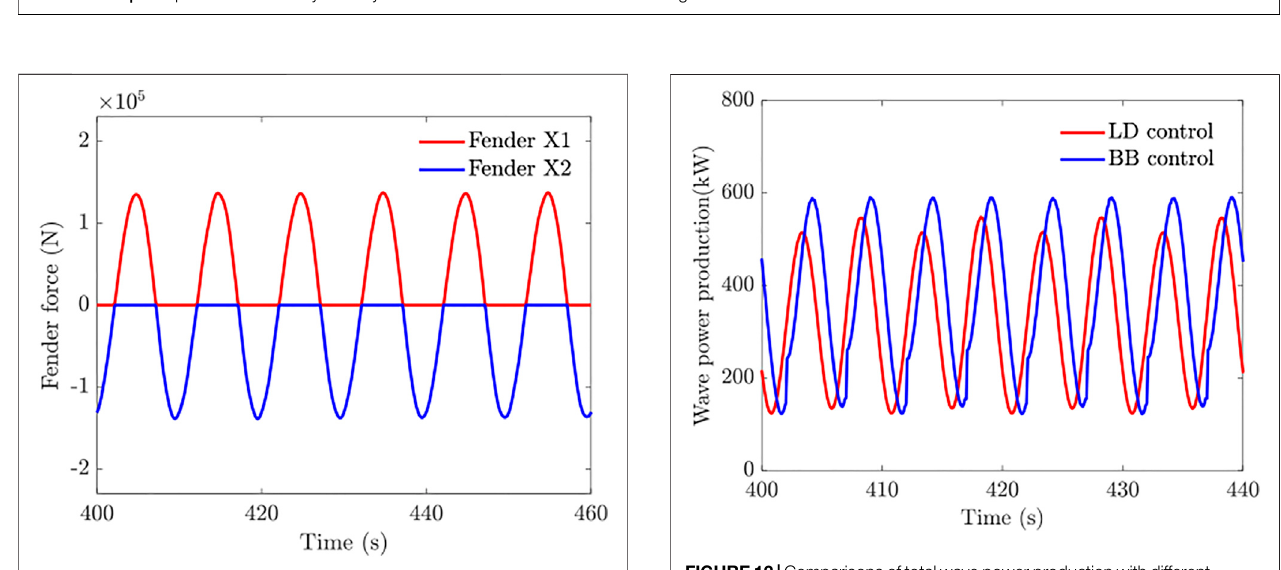
FIGURE 10 | Comparisons of PTO system dynamics with different PTO control strategies for WEC 1.